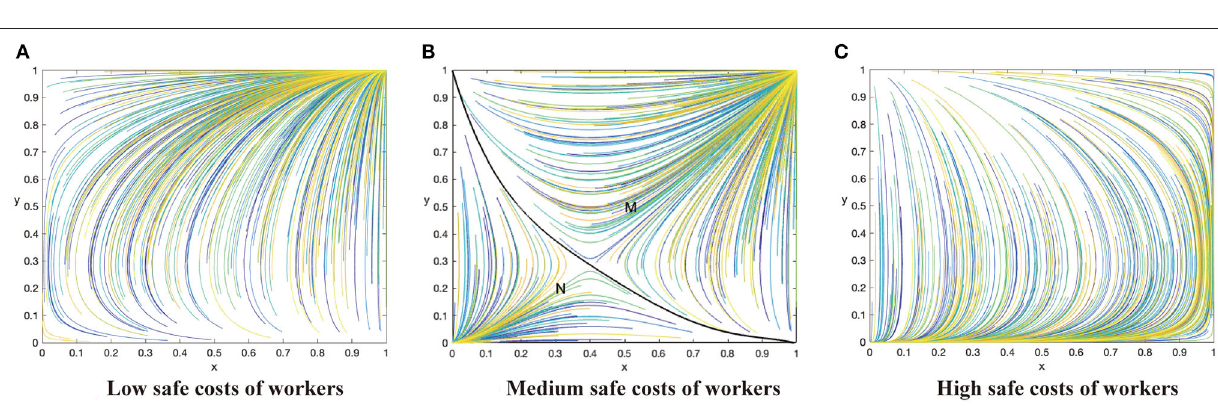
− p 1 ) L , which is the 2